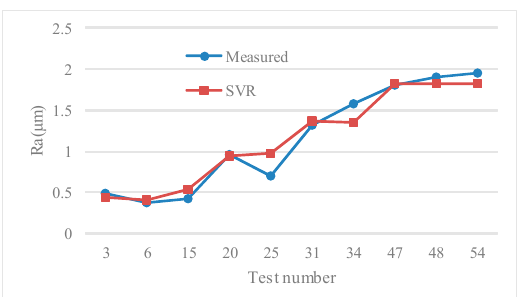
Figure 10. Heat map of grid search parameters.